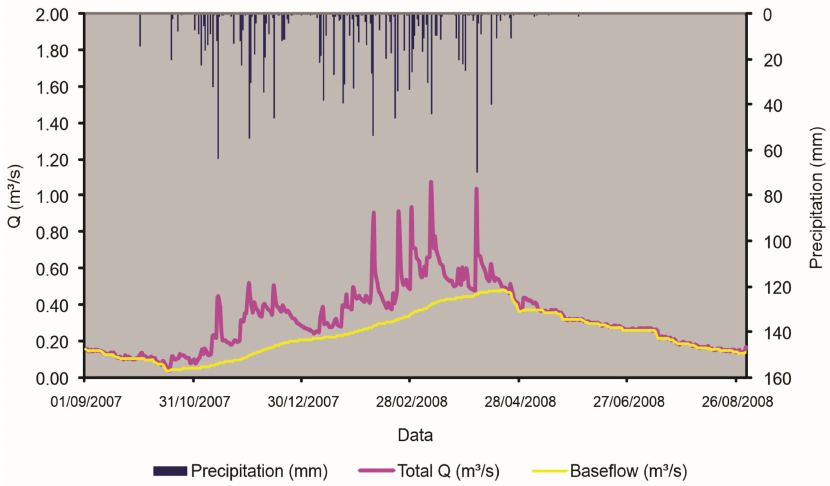
Figure 13. Hydrographof surface flow and baseflow for